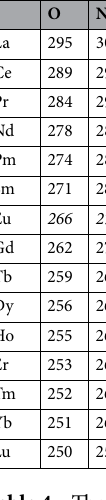
Table 4. The target coordinate bond lengths (pm) between divalent lanthanoid ions and the types of coordinating atoms found in our dataset. Values in Italic were computed directly from the data, whereas the remaining values had to be extrapolated by using Europium as the argument